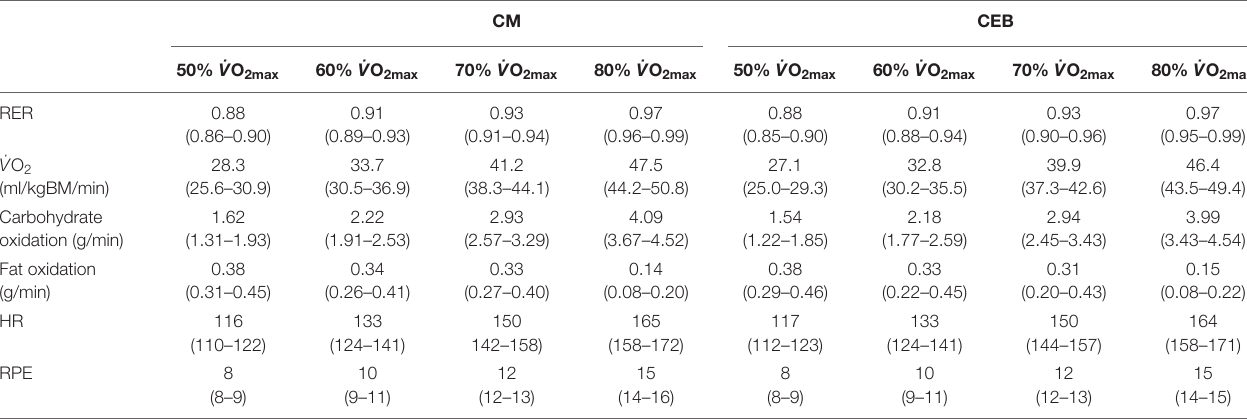
TABLE 3 | Physiological and performance outcomes of graded exercise intensity using breath-by-breath testing between 50–80% ˙V O 2max and 1 h self-paced distance performance test, following consumption of dairy milk (CM) and carbohydrate-electrolyte (CEB) recovery beverages the previous